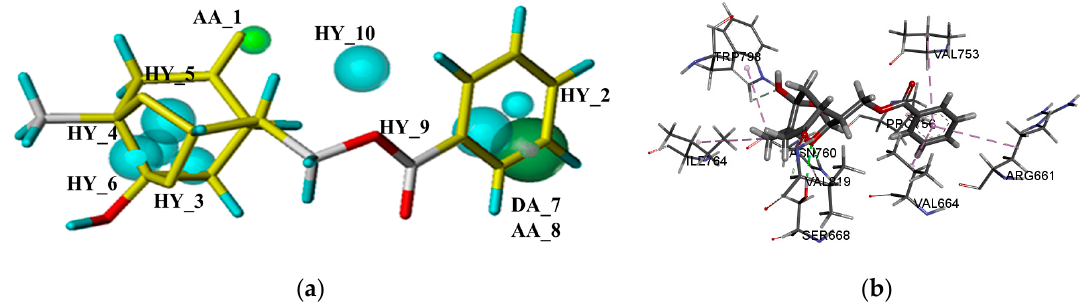
Figure 7. ( a ) The mapping results of Paeoniflorigenone with the best pharmacophore of allosteric site of mGluR І ; ( b ) the docking result of Paeoniflorigenone with the crystal structure of mGluR1.